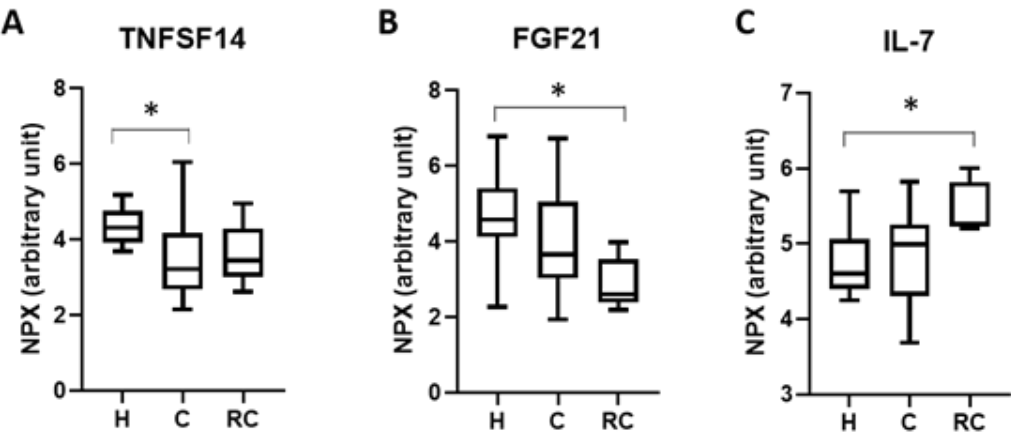
Figure 1. Differentially expressed proteins in human serum from healthy (H), concussed (C), and repetitively concussed (RC) patients. TNFSF14 ( A ) was found to be significantly reduced in concussed patients when compared to healthy individuals. In contrast FGF21 ( B ) was significantly downregulated and IL-7 ( C ) was significantly upregulated in repetitively concussed patients. Data is presented as the mean ± SE and was tested for normality followed by a one-way Anova and a tukey post hoc test where * p < 0.05. H = 12 C = 18 RC = 5.